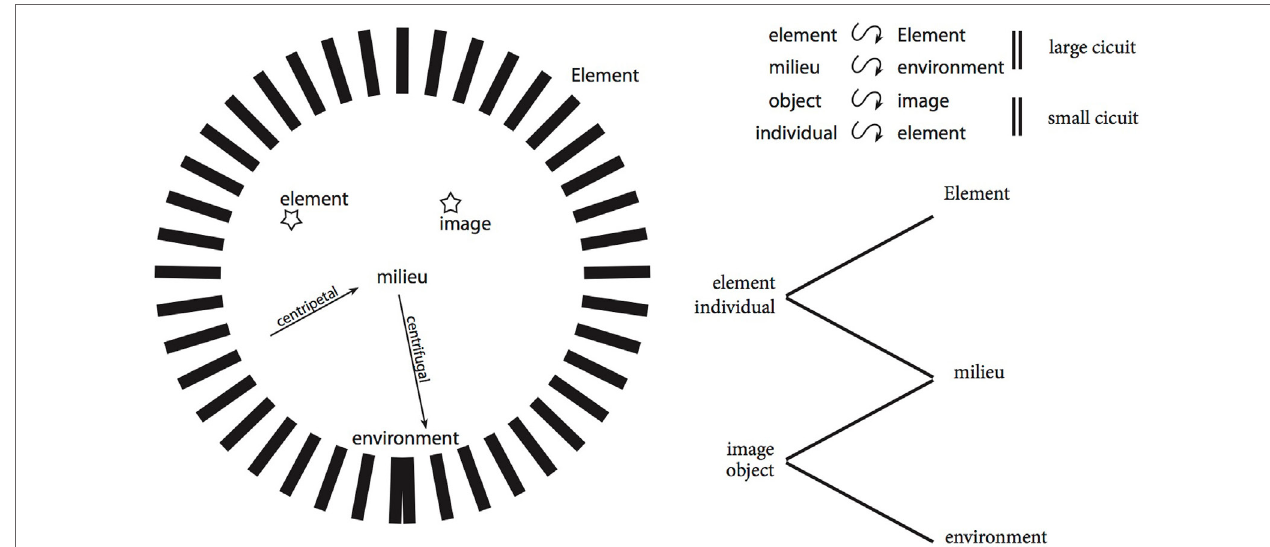
FigUre 3 | The fibre of the